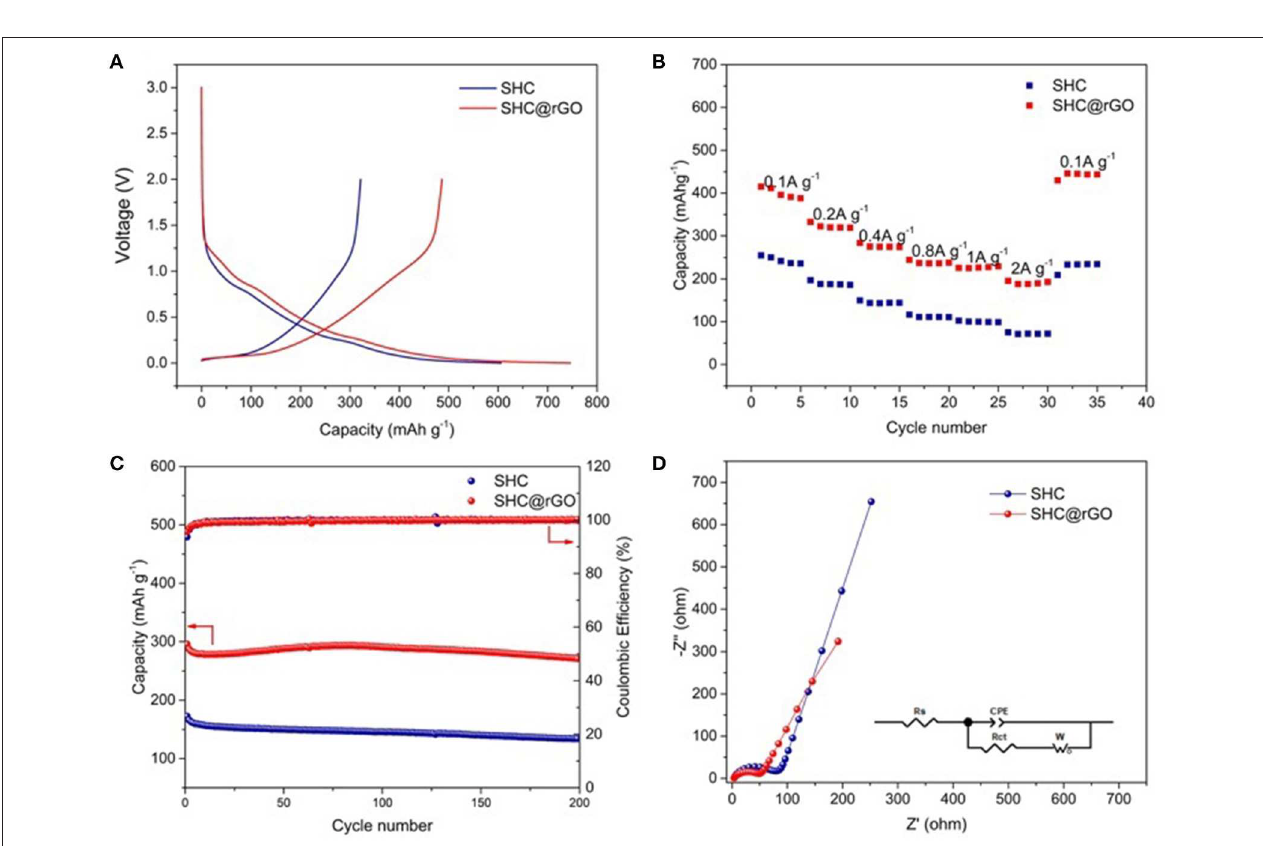
FIGURE 6 | (A) CV curves of SHC and SHC@rGO in the first cycle and (B) CV curves of SHC and SHC@rGO in the second cycle.